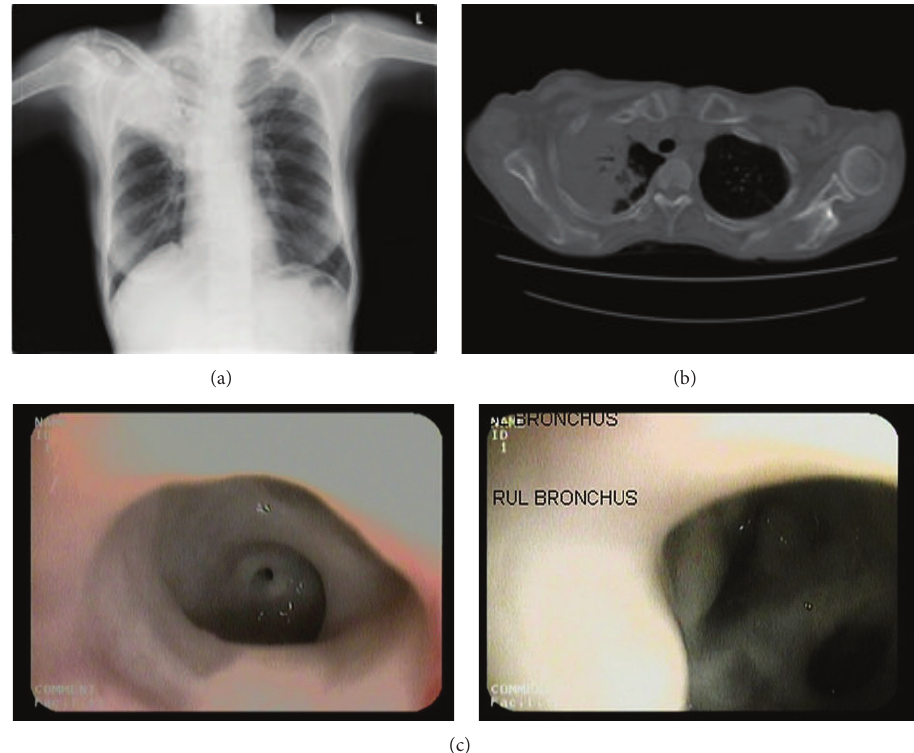
Figure 1: (a) Chest X ray at presentation showing right upper lobe homogenous opacity. (b) CT chest showing dense peripheral consolidation of the right upper lobe. (c) Bronchoscopic picture of right upper lobe showing cheesy pseudomembrane lining the right upper lobe bronchial